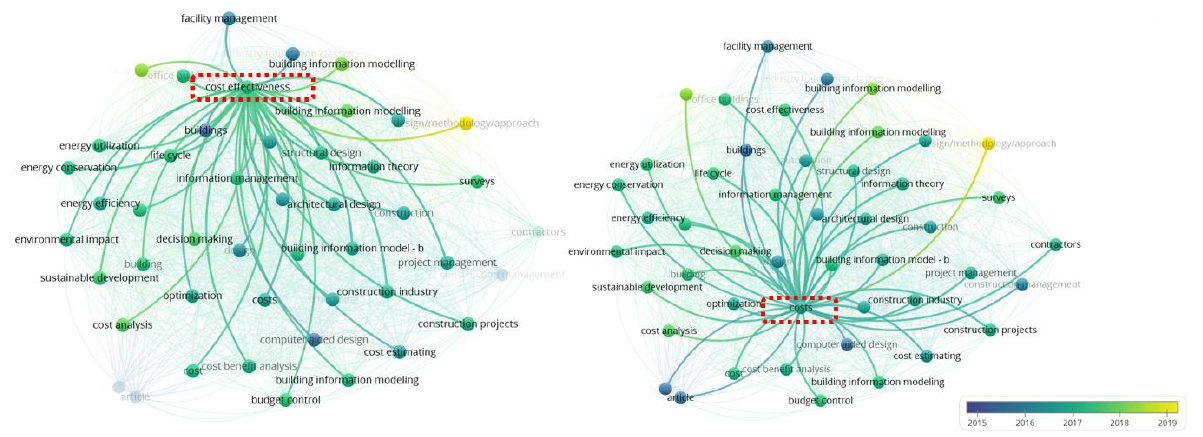
Figure 5. Co-occurrence analytical network of keywords identified from the merged CCM dataset. Note: with the minimum number of co-occurrences of 2, 1151 out of 5671 keywords are identified using the greatest total link strength.